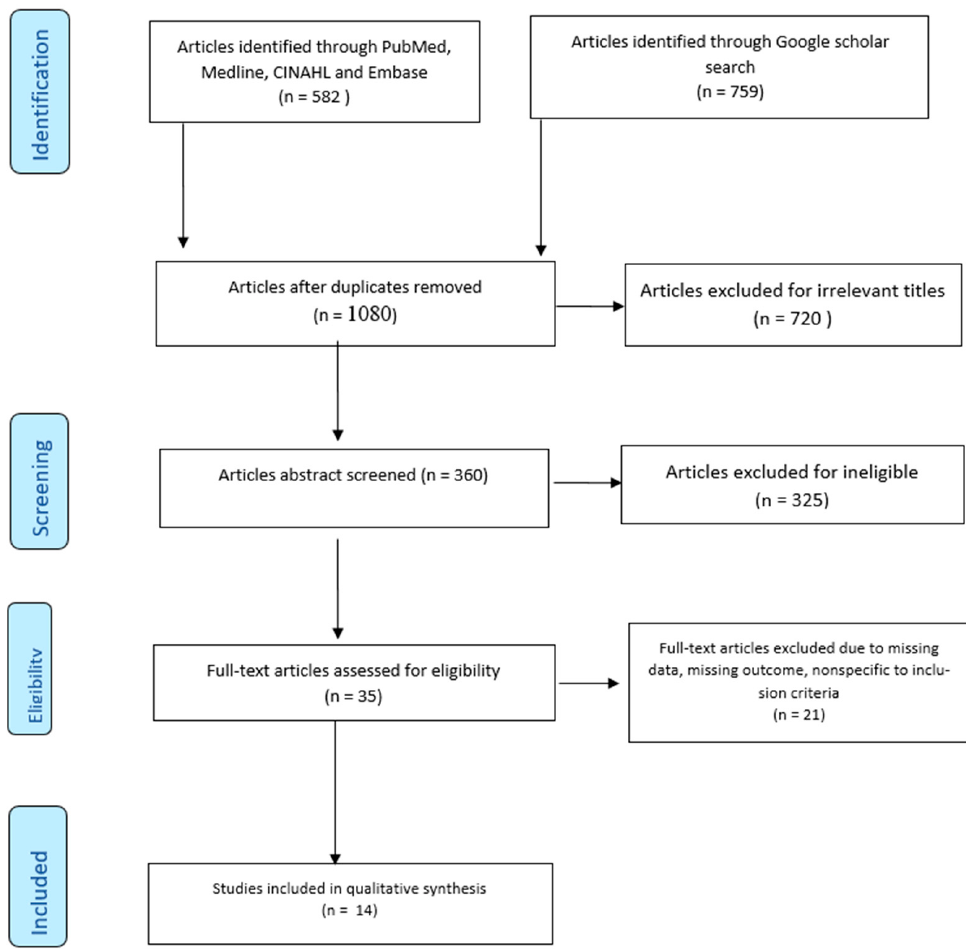
Figure 1. PRISMA flow diagram for the systematic literature review.